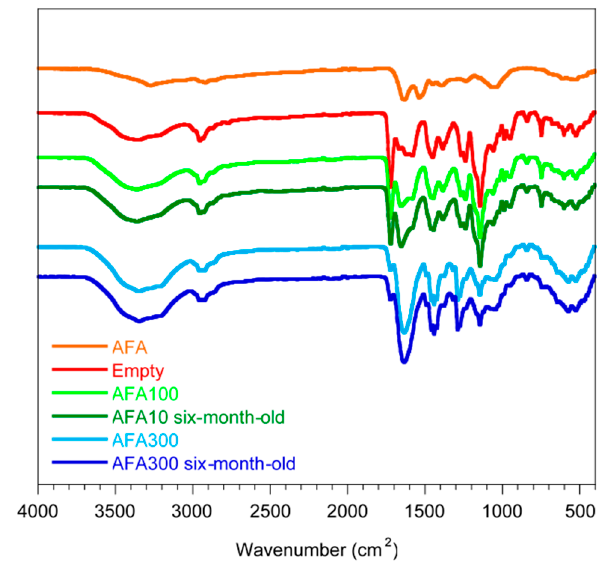
Figure 12. ATR-FTIR Spectra of Six-month-old AFA100 and AFA300 films compared to AFA raw material, empty film, and AFA100 and AFA300 freshly prepared.